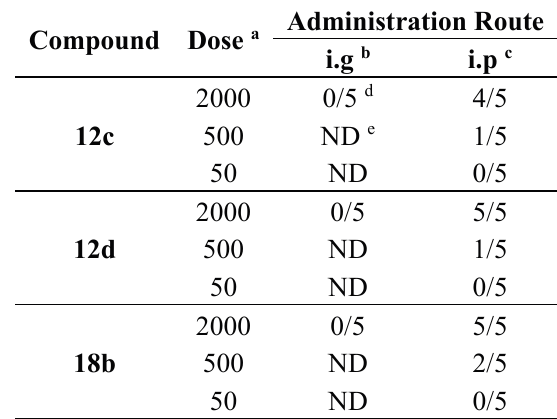
Table 3. The acute toxicity of compounds in preliminary test.